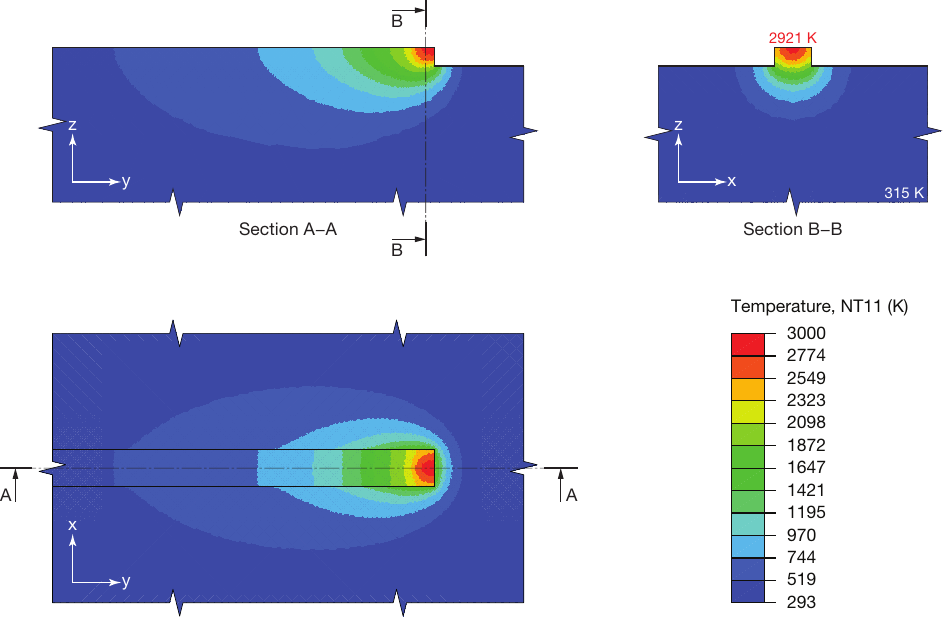
Figure 7. Temperature distributions on the top and in two cross-sections for Set